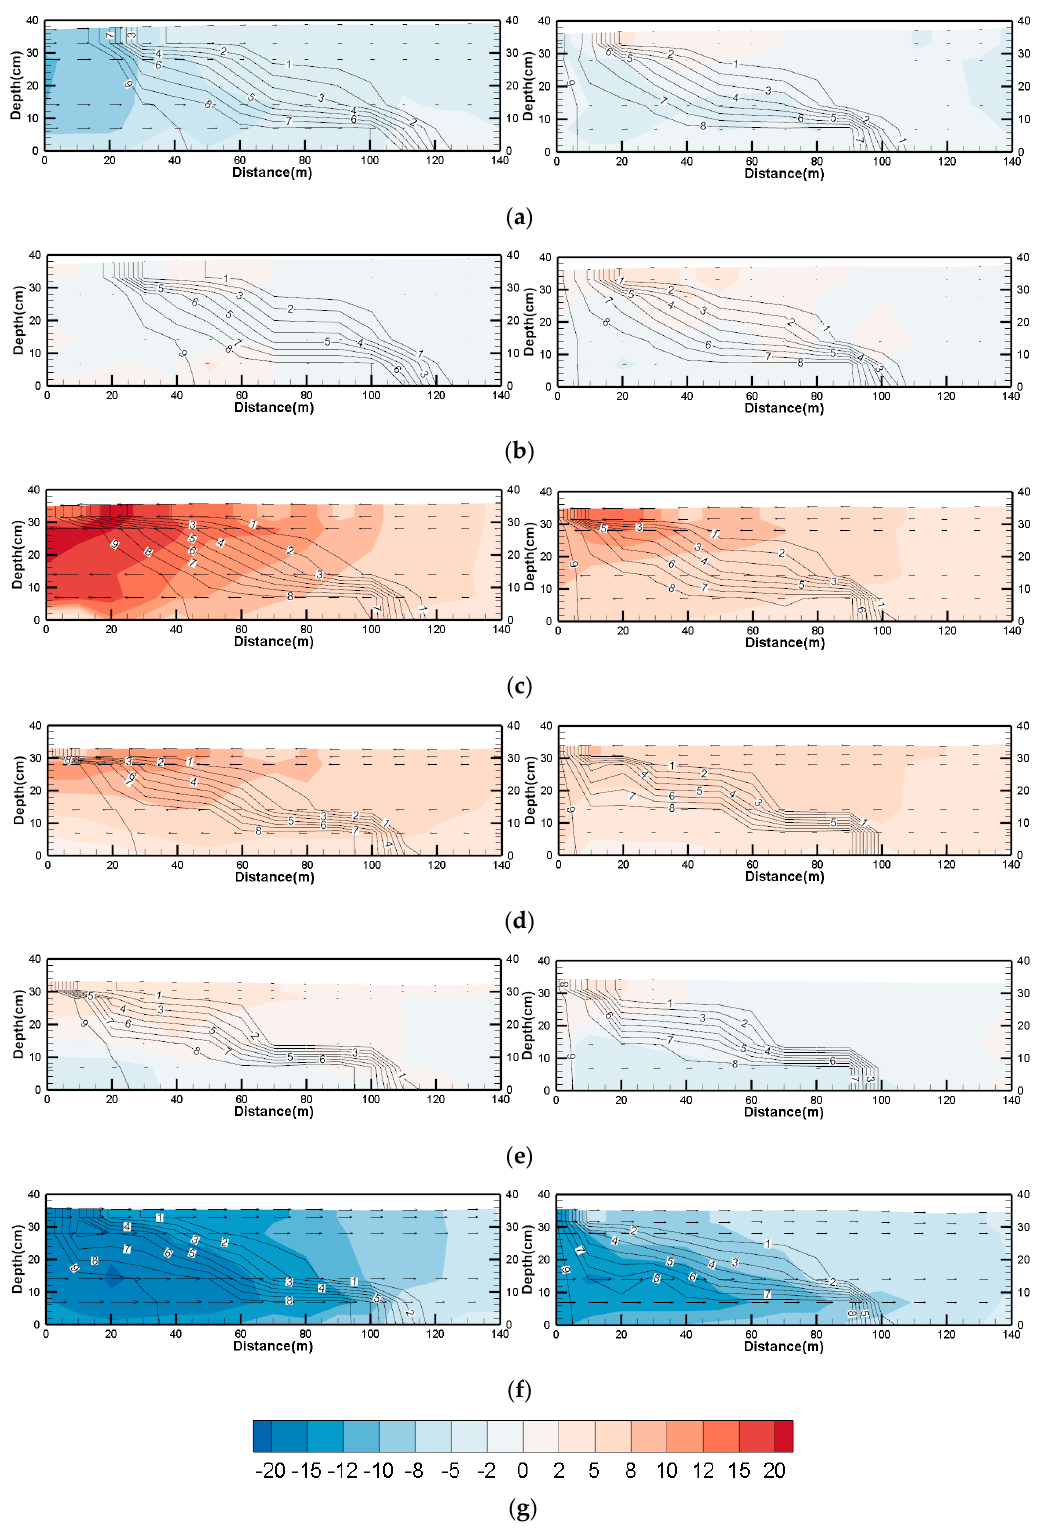
Figure 3. Salinity and velocity profiles of Case 1 (left figures) and Case 2 (right figures) at each characteristic moment. The tidal ranges of Case 1 and Case 2 are respectively 4 cm and 2 cm, when the other conditions are shown in Table 1. ( a ) High water; ( b ) Flood slack; ( c ) Maximum ebb; ( d ) Low water; ( e ) Ebb slack; ( f ) Maximum flood; ( g ) Legend of velocity (unit: cm/s). The arrow represents the flow direction. The contour represents the isohaline.